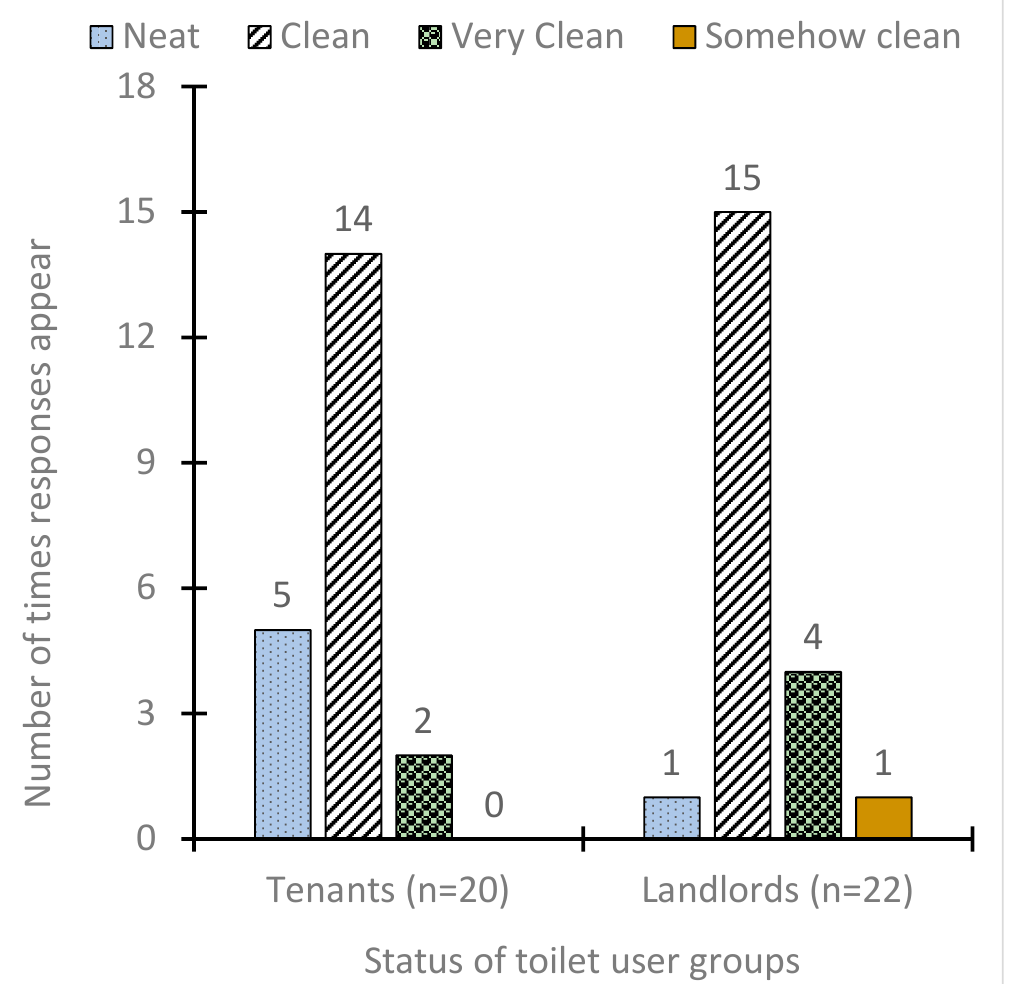
Figure 2. Perception of users regarding compound toilet cleanliness.